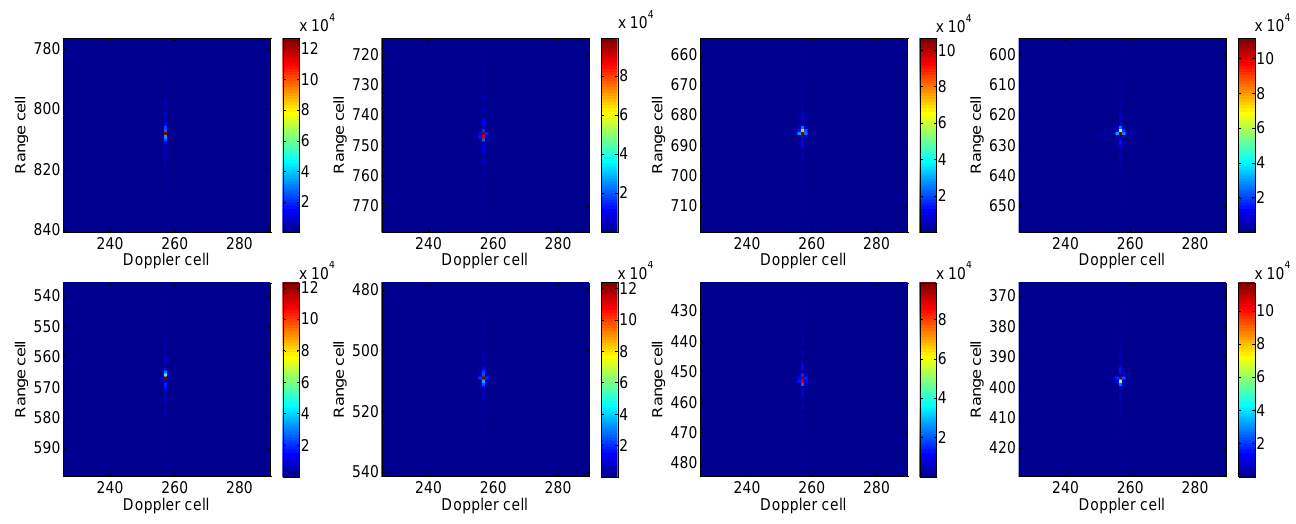
Figure 4. Subaperture processing results. The whole aperture is divided into 8 subapertures, and all 8 subaperture images are well focused by the proposed HPC-GMTIm algorithm.